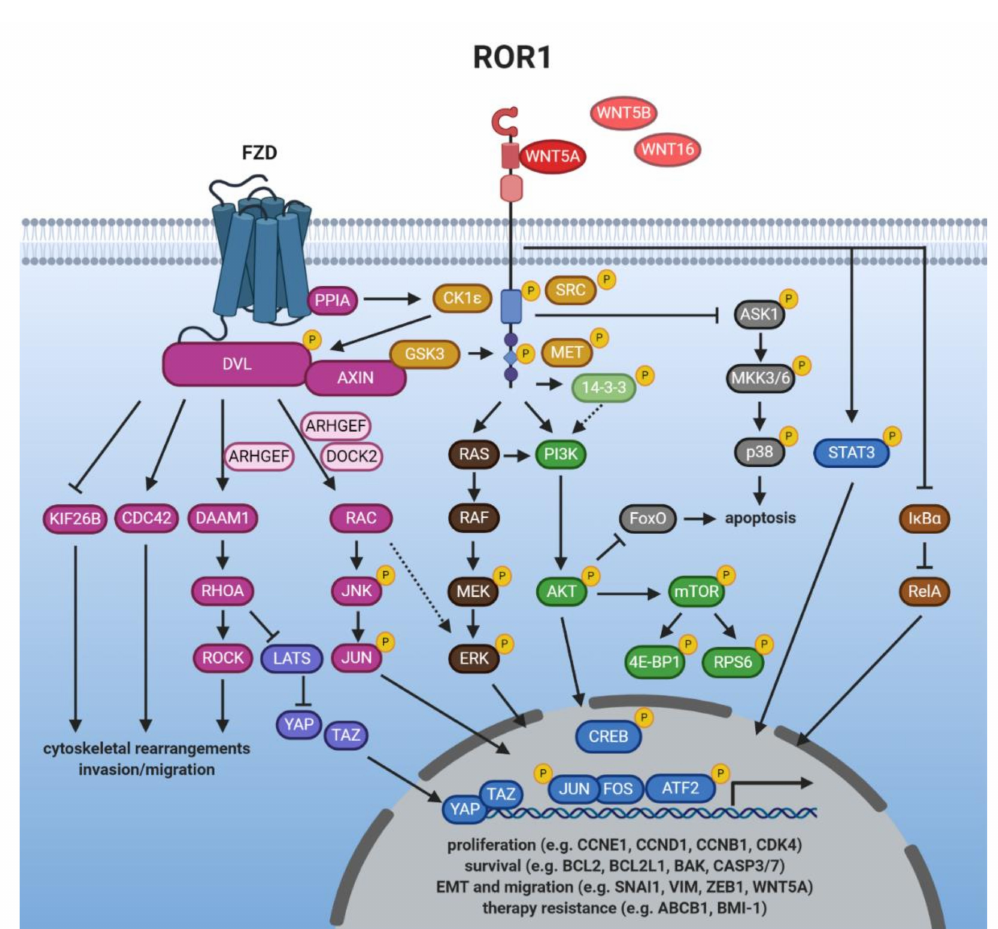
Figure 2. ROR1 signaling. WNT/ROR1 signaling is induced by binding of a non-canonical WNT ligand, which triggers the formation of a complex between ROR1 and ROR2, or ROR1 and a FZD receptor, respectively. Signal transduction is mediated by the phosphorylation of ROR1 by several kinases (orange) which on the one hand results in the inhibition of anti-apoptotic pathways (grey), while on the other hand activates downstream pathways such as WNT/PCP (magenta), MAPK/ERK (dark brown), PI3K/AKT (green) or NF- κ B (light brown). These either trigger cytoskeletal rearrangements associated with enhanced tumor cell migration, or induce a transcriptional response (blue) leading to the expression of genes which promote cell proliferation, survival, EMT, or therapy